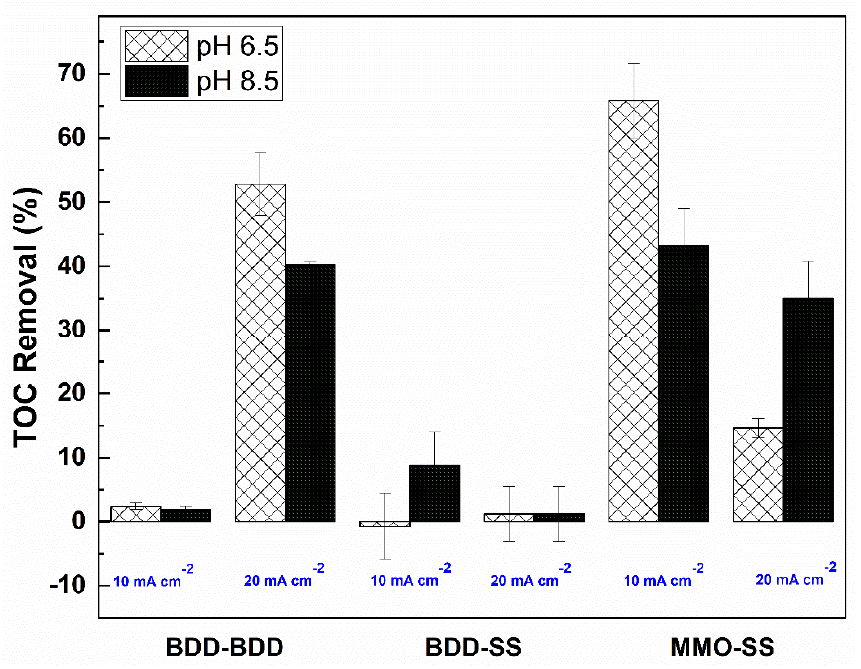
Figure 2. TOC removal after 120 min EO treatment with BDD and MMO anodes at pH 6.5 and 8.5 and current densities of 10 and 20 mA cm − 2 . Error bars show standard deviation.